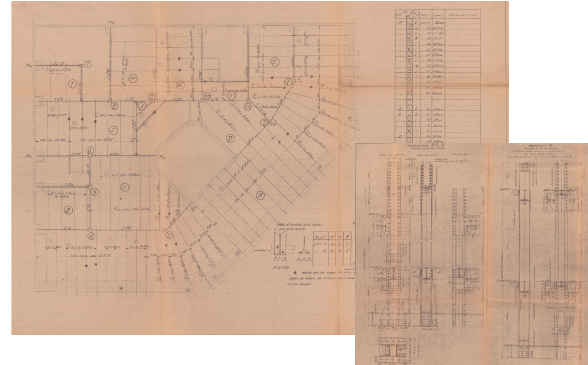
Figure 9. Special Protection Plan of Ciutat Vella: State of preservation map. (Source: Ayuntamiento Valencia).